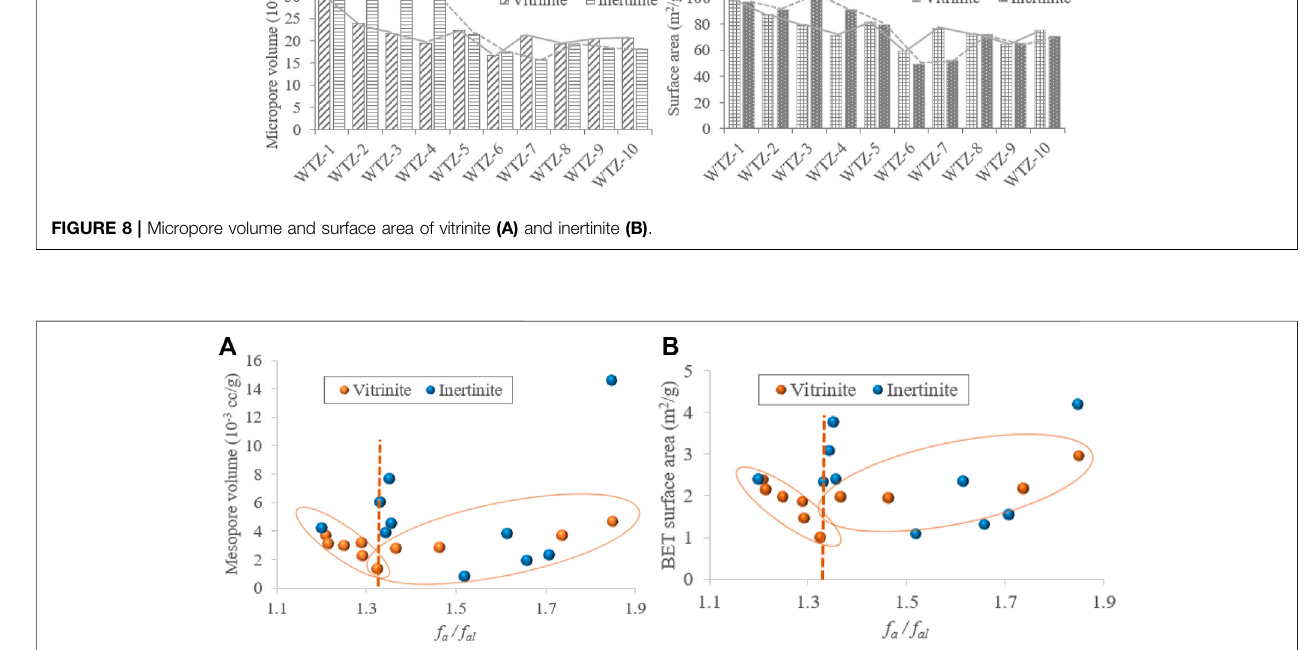
FIGURE 9 | Relationships between the f a /f al and mesopore volume (A) , f a /f al and BET surface area (B) .